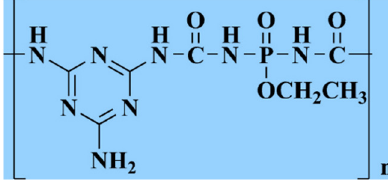
Figure 6. Structure of PMPC.